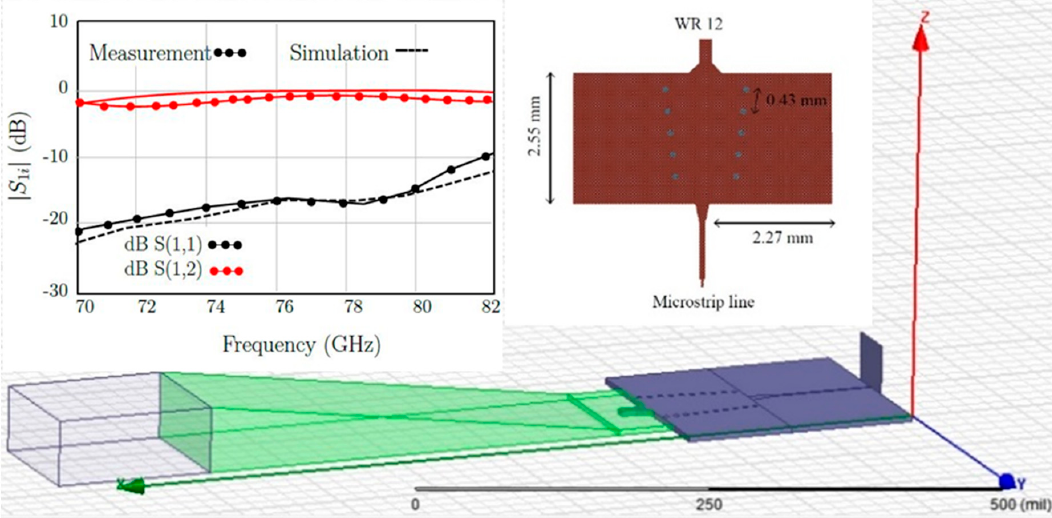
Figure 10. Microstrip to WR-12 transition: S-parameters and dimensions.